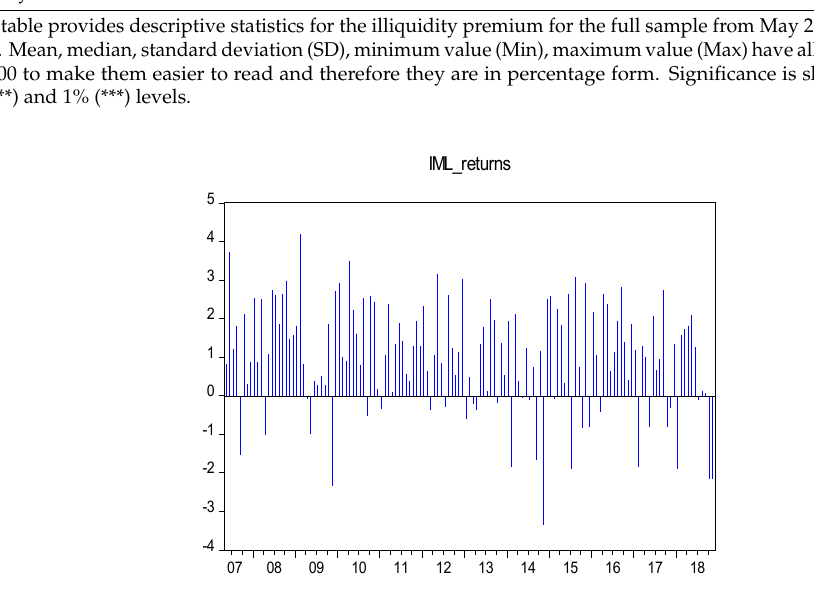
Figure 1. Time series variation in illiquidity premiums.